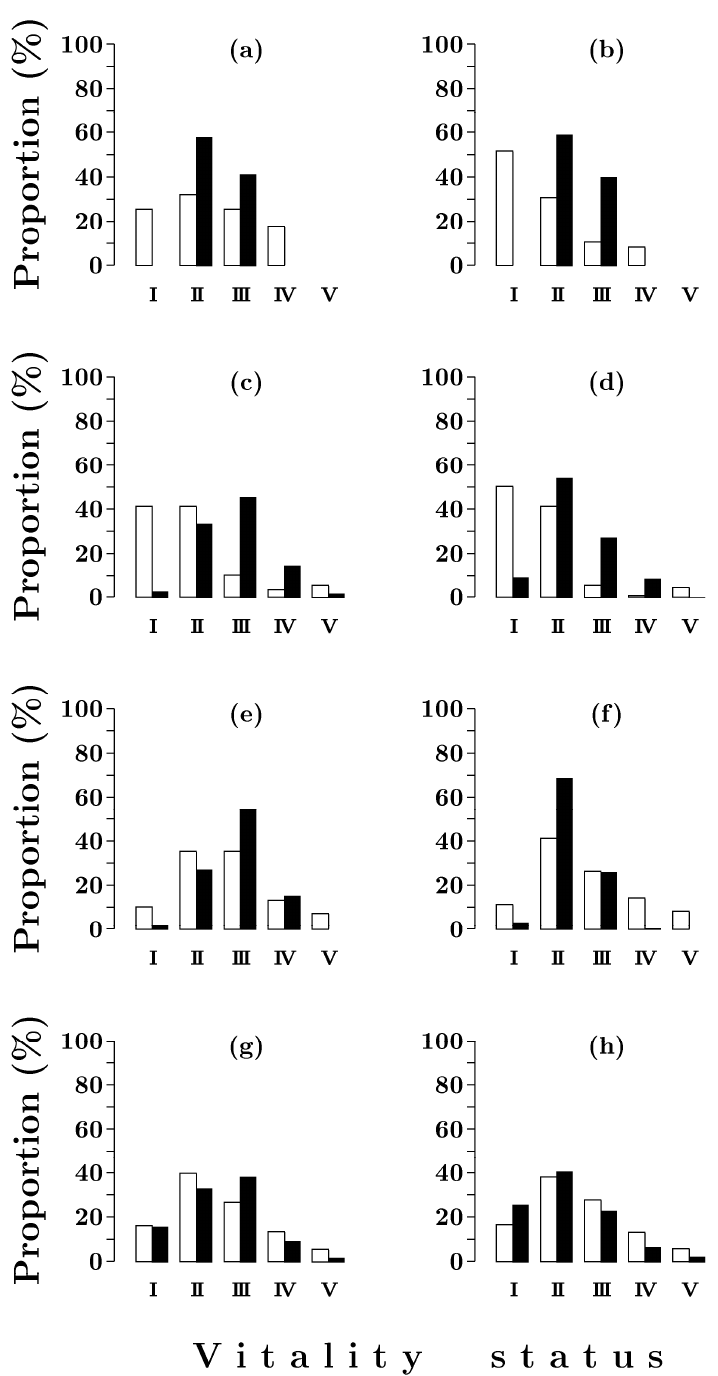
Figure 3. Vitality class distributions of Pinus sylvestris (open bars) and Picea obovata (solid bars) trees in forests with post-fire periods of 80 ( a , b ), 150 ( c , d ), 200 ( e , f ) and 380 ( g , h ) years. I–V—vitality status: I—healthy trees; II—moderately weakened trees; III—strongly weakened trees; IV—dying trees; V—dry trees. a, c, e, g—by number of individuals; b, d, f, h—by